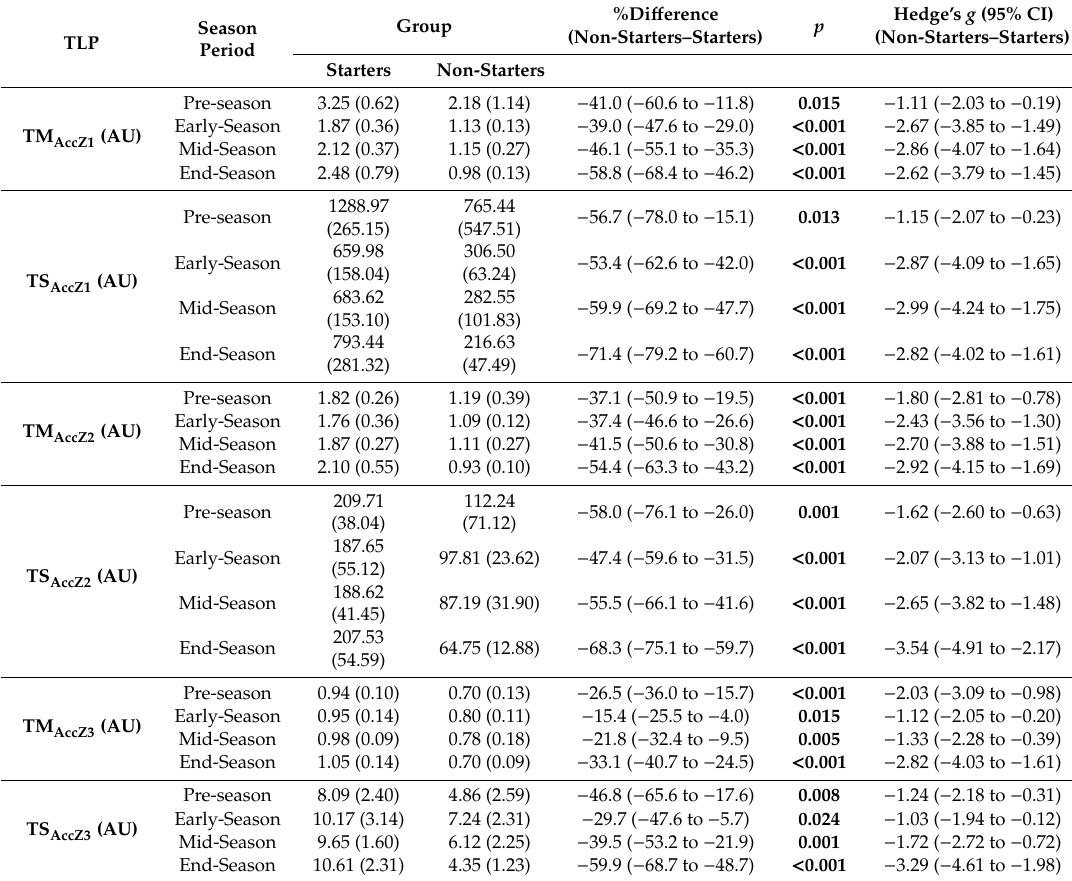
Table 2. Di ff erences between starters and non-starters in terms of training monotony and training strain based on acceleration-derived GPS variables in the full season and its di ff erent